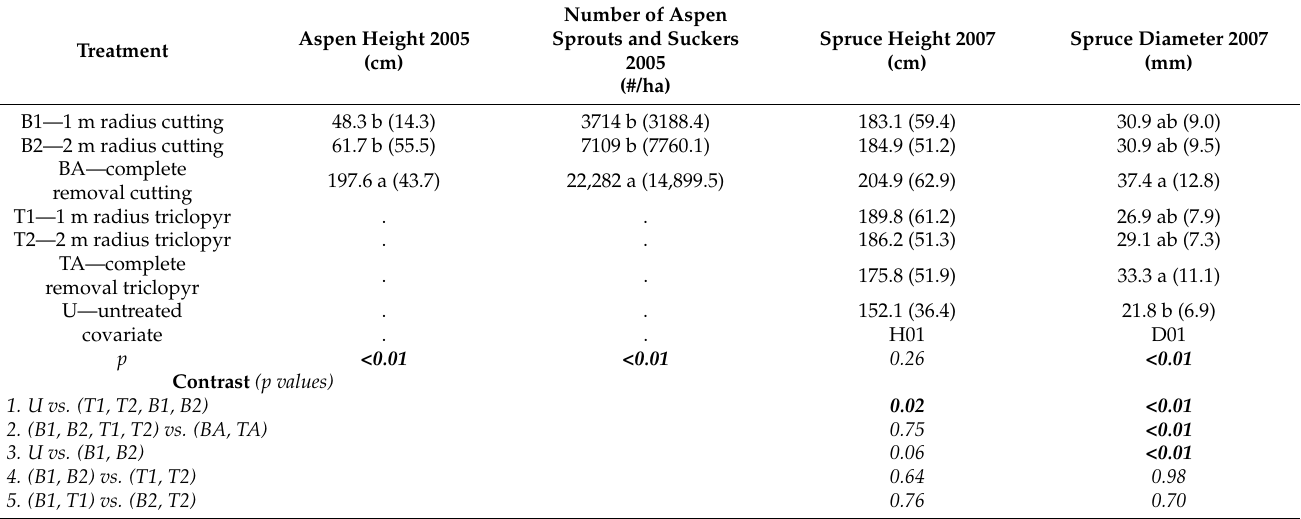
Table 1. Treatment effects on aspen height, number of aspen sprouts in 2005 and spruce height and diameter in 2007 for the Mistahae study. Analysis of treatment effects on spruce size is based on analysis of covariance, using height or diameter in 2001 as a covariate. Letters in each column indicate significant differences detected using Scheffe’s Test at α = 0.05. SD shown in brackets. Significant p values ( α = 0.05) are shown in